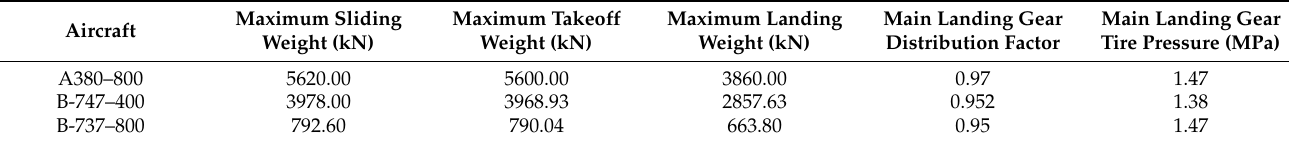
Table 2. Aircraft parameter